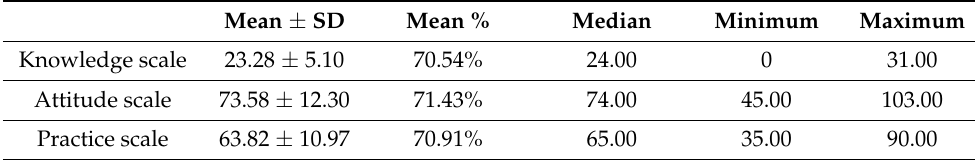
Table 3. Description of the KAP toward cholera